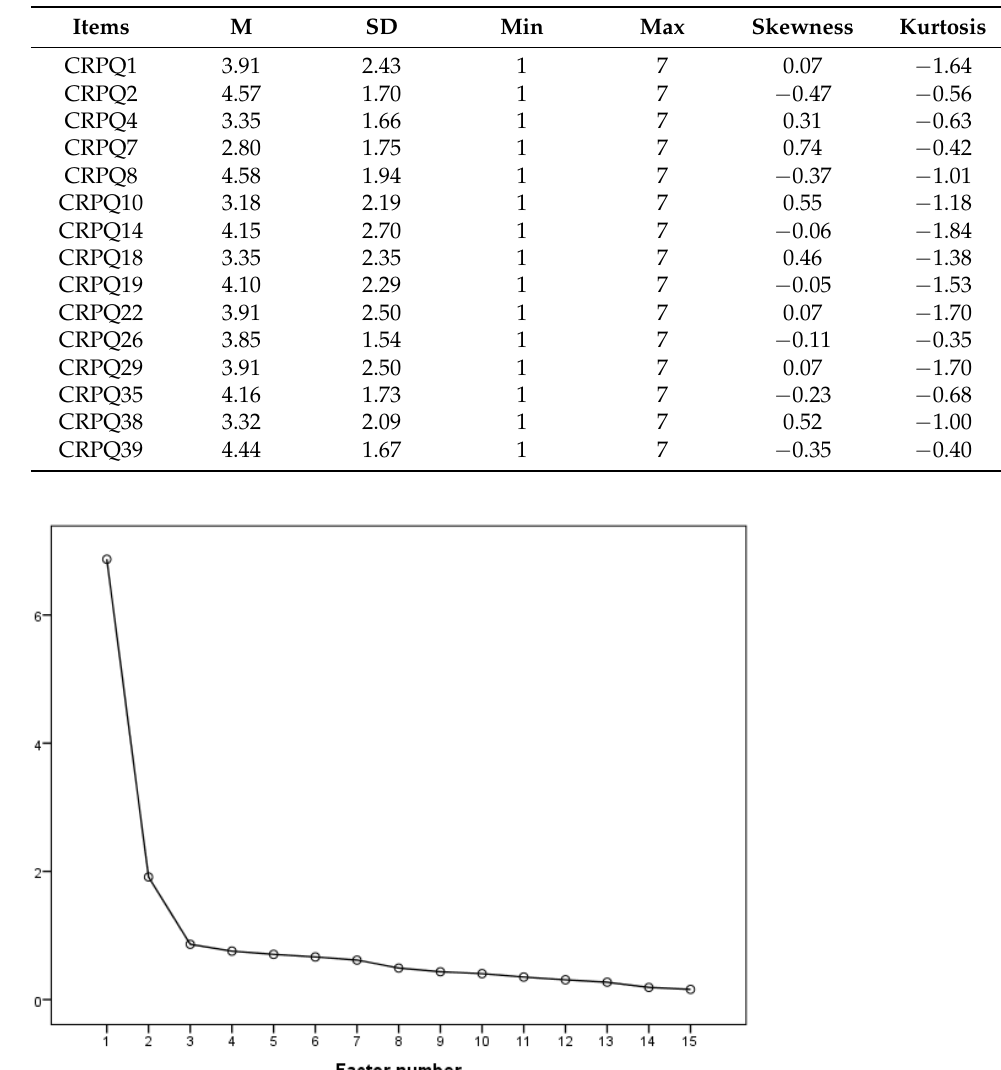
Table 2. Descriptive statistics for items of the CRPQ (Sample 1).